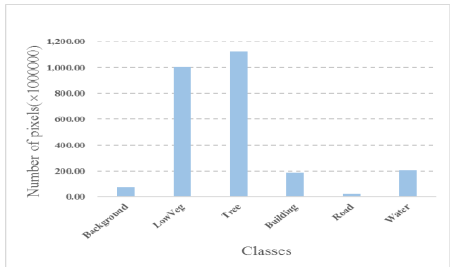
Figure 4. The pixel number of each class in the dataset